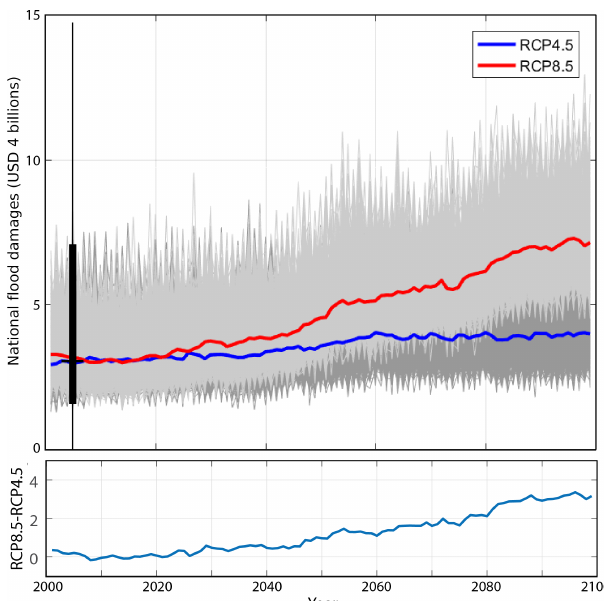
Figure 7. (a) Projected national flood damages within 100-year flood zones, in 2014 dollars. The thin grey lines are 1000 simula- tions of damages for RCP 4.5 (dark grey) and RCP 8.5 (light grey). Blue and red lines are means of simulations for the two RCPs. The box and whisker plot on the left is the range of historical observed flooding in the CONUS between 1903 and 2014 (10 outliers not shown). (b) Difference between mean annual flood damages be- tween RCP 4.5 and RCP 8.5 (billions of 2014 US dollars).